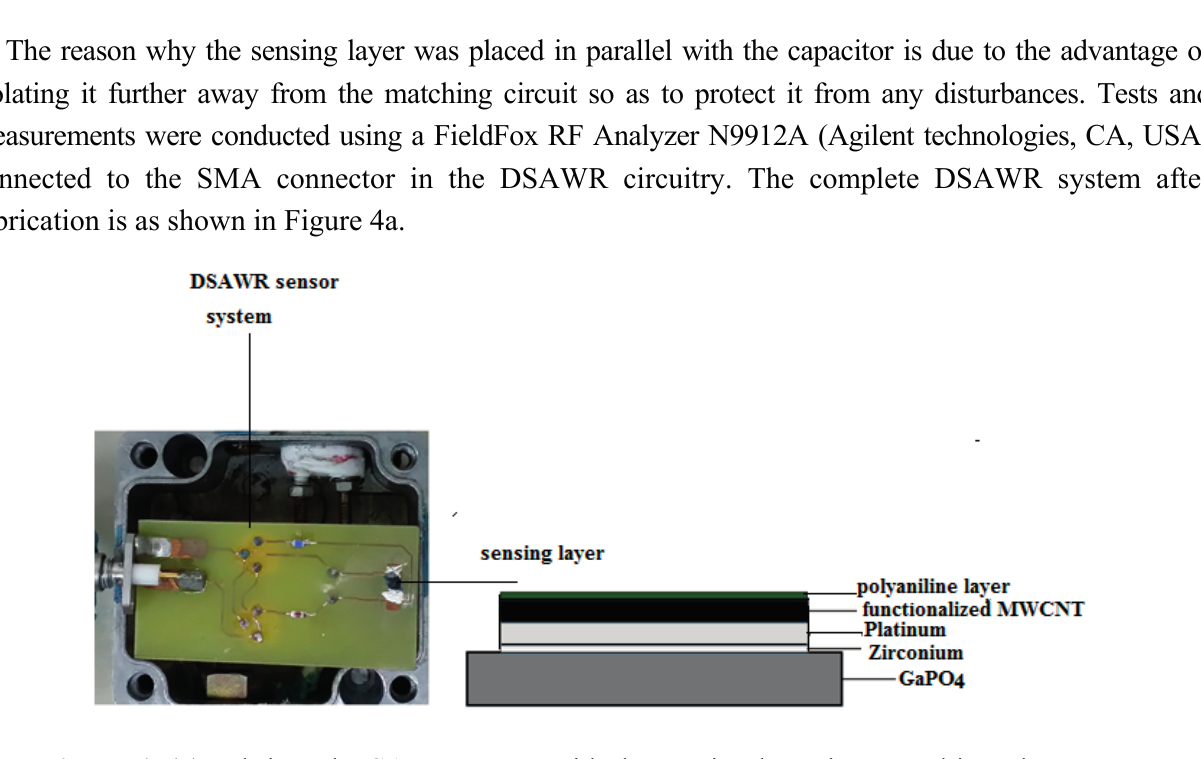
Figure 4. ( a ) Fabricated DSAWR sensor with the sensing layer integrated into the system placed in a test cell; ( b ) Side view of the sensing layer (thickness not to